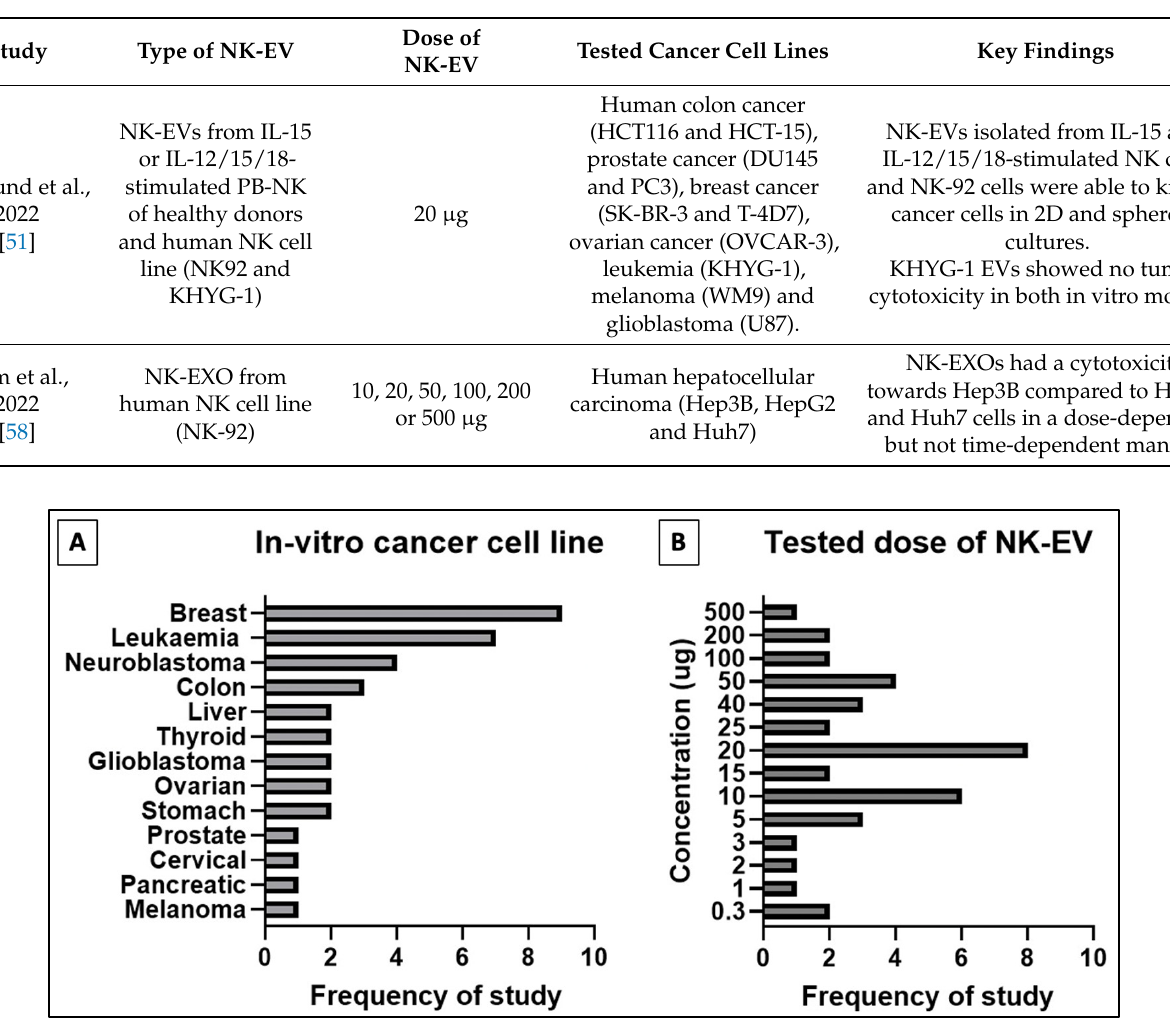
Figure 2. Distribution of in-vitro studies for ( A ) type of cancer cell line studied and ( B ) tested doses of NK-EVs for cancer cell cytotoxic assay.